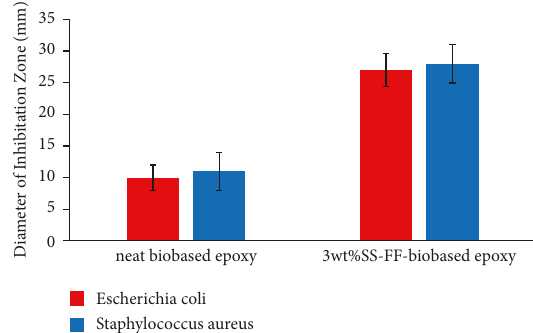
Figure 10: Antibacterial activity of pristine biobased epoxy and 3 wt% SS-FF-loaded biobased epoxy against E. coli and S. aureus